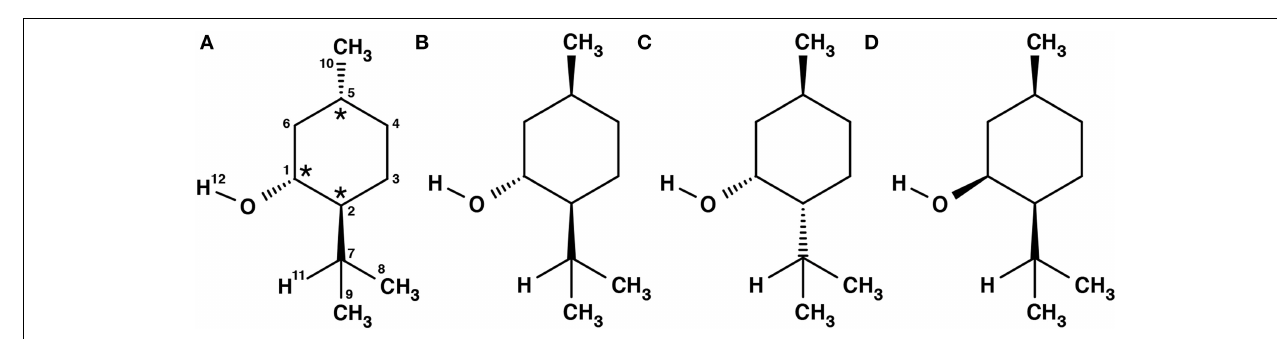
FIGURE 1 | Schemes of the structures of the (-)-enantiomers of the different stereoisomers of menthol: (A) (-)-menthol, (B) (-)-isomenthol, (C) (-)-neomenthol, (D) (-)-neoisomenthol. In